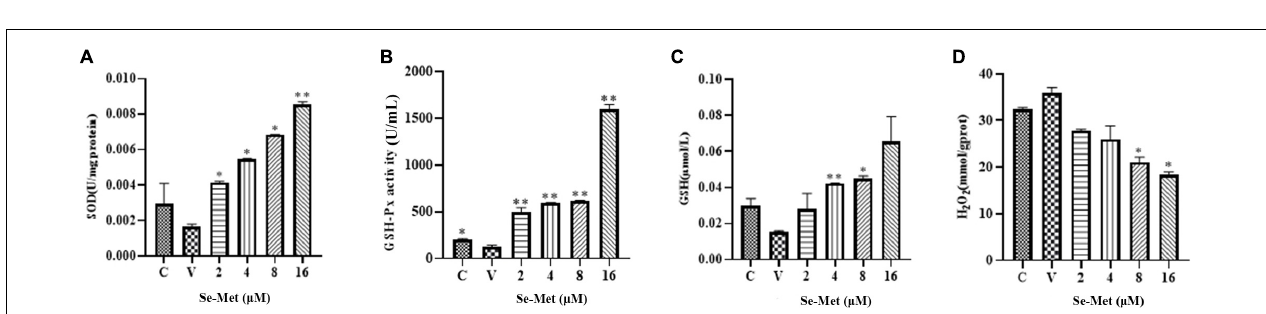
FIGURE 3 | Effects of Set-Met on the changes of IFN- α / β in cells induced by PDCoV. LLC-PK cells were incubated with PDCoV for 1 h, and 2, 4, 8, and 16 µ M of Se-Met was added. Changes in IFN- α / β were detected by ELISA (A,C) and RT qPCR (B,D) . ∗ 0.01 < P < 0.05, ∗∗ P < 0.01.